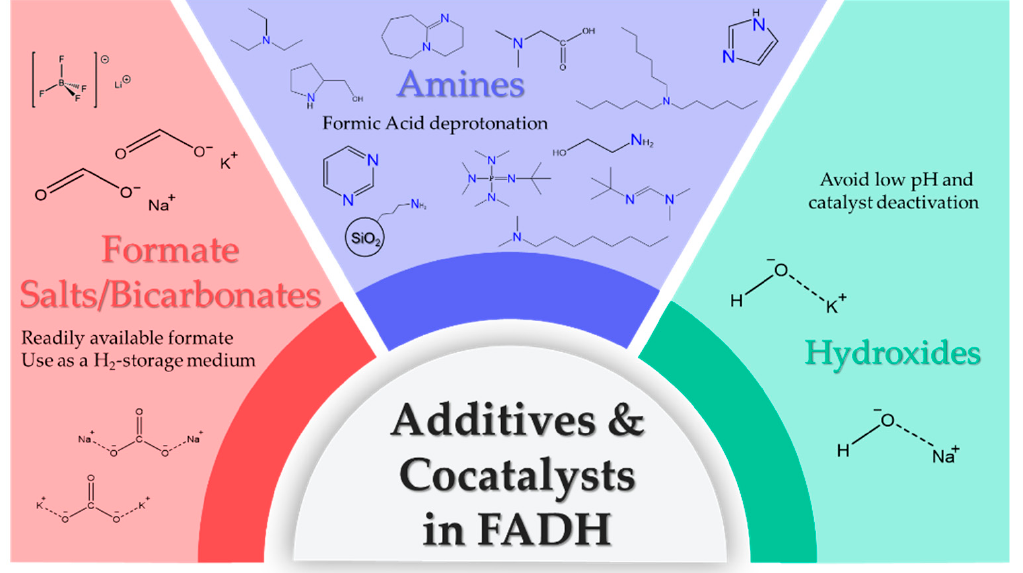
Figure 12. Some additives and cocatalysts utilized in FA dehydrogenation.